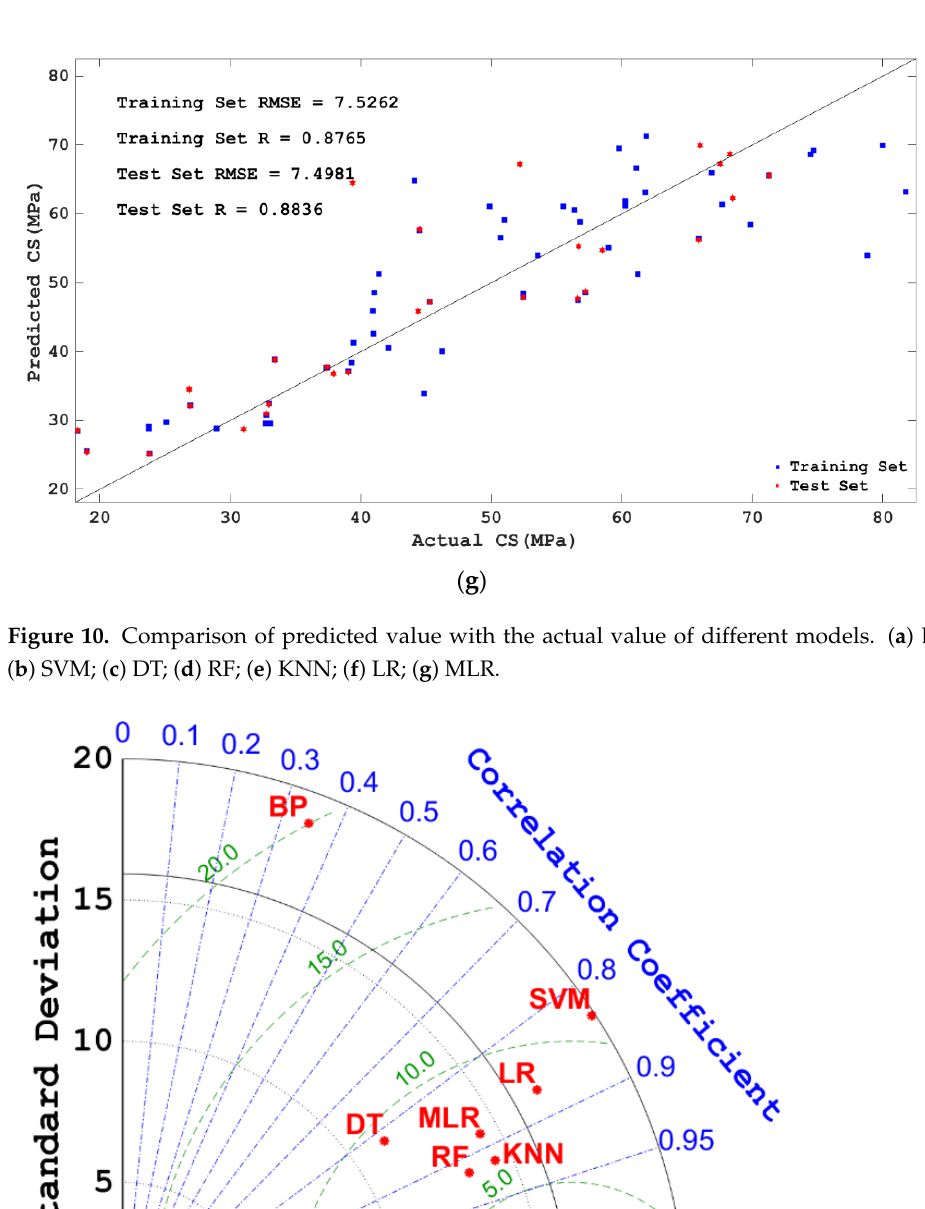
Figure 10. Comparison of predicted value with the actual value of different models. ( a ) BPNN; ( b ) SVM; ( c ) DT; ( d ) RF; ( e ) KNN; ( f ) LR; ( g ) MLR.